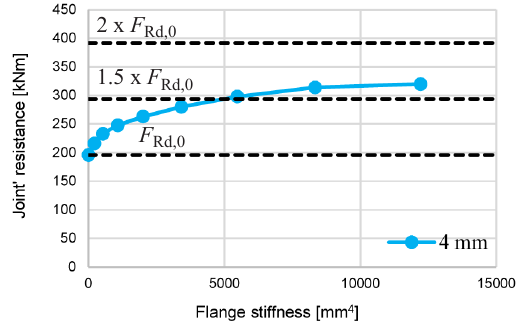
Fig. 18. Relation between joint resistance and flange